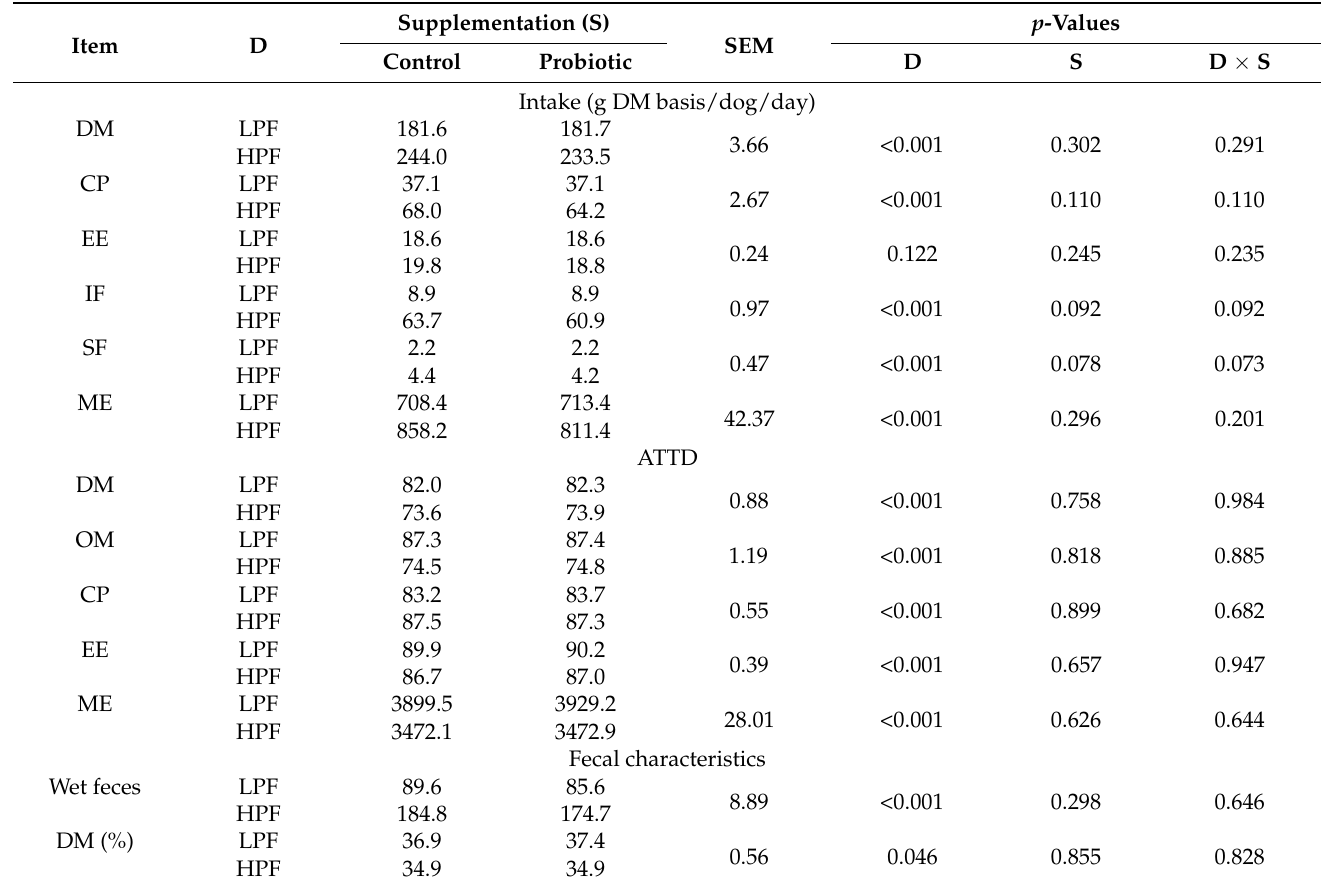
Table 2. Means in dry matter (DM) and nutrient intake, coefficients of total tract apparent digestibility (ATTD, %) of nutrients, metabolizable energy (ME, kcal/kg), and fecal characteristics of dogs fed a lower protein and fiber (LPF) or a higher protein and fiber (HPF) diet (D) without (control) or with (probiotic) yeast supplementation